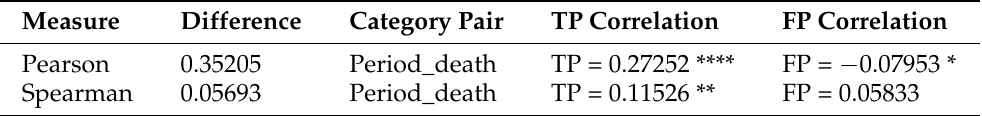
Table 19. Periods and Death in High.